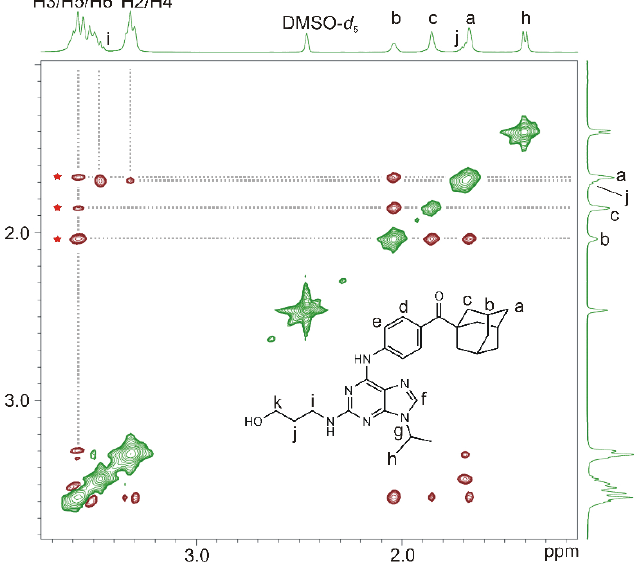
Figure 3. Portion of ROESY spectrum recorded for the 11.4 mM solution, consisting of purine 4d and β-CD with a 1:1 molar ratio (D 2 O:DMSO- d 6 , 1:2, v : v ; 303 K). The cross-peaks related to the intermolecular contacts inside the β-CD cavity are indicated by red stars. H2–H6 are H-atoms with glucose units of β-CD.